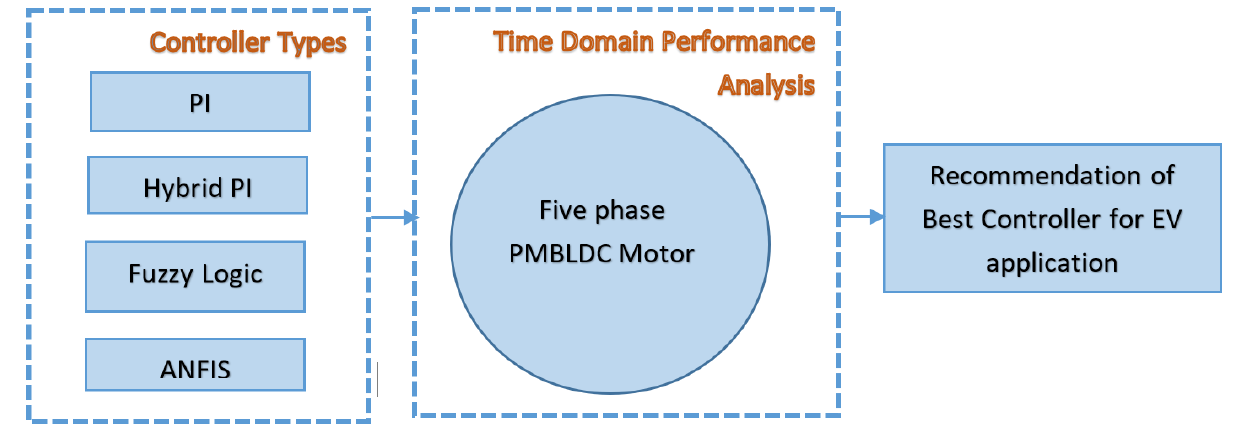
Figure 1. Technical drawing of the proposed work.